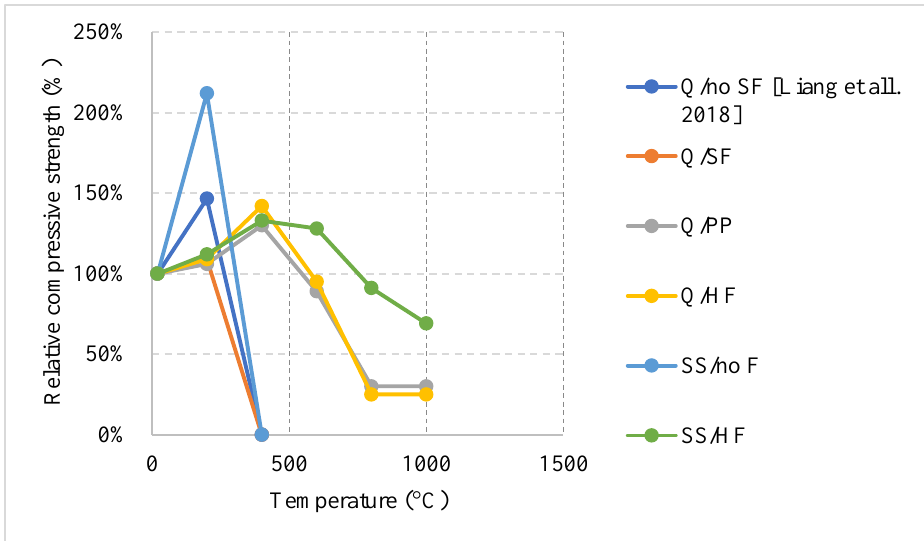
Figure 26. Relative compressive strength of naturally cooled UHPC (heated versus not heated). Q: Quartz, SF: Steel fiber, PP: Polypropylene fibers, HF: Hybrid Fibers, SS: Steel Slag [93].